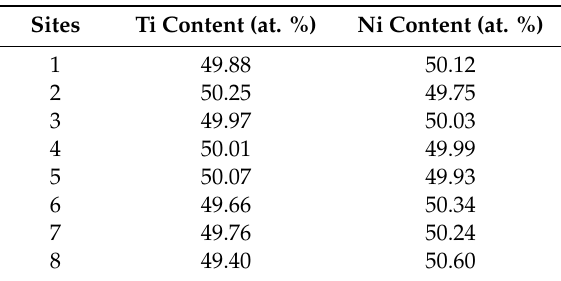
Table 2. Quantitative compositional results from EDS measurements, performed in the planar x–y view. The indication regarding the localization of the region of measurement is indicated in Figure 4a,c. For all measurements, an average 0.3% sigma was obtained. Sites Ti Content (at. %) Ni Content (at. %)